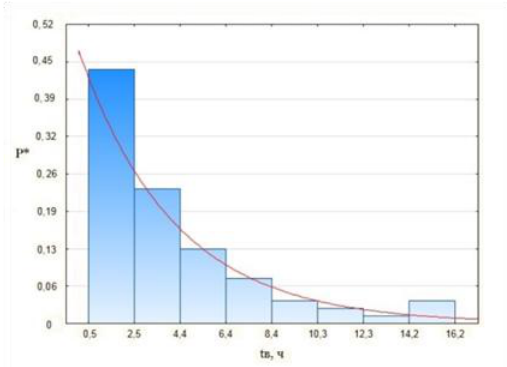
Figure 6. Histograms and distribution frequency functions of restoring time of management system of rope shovels